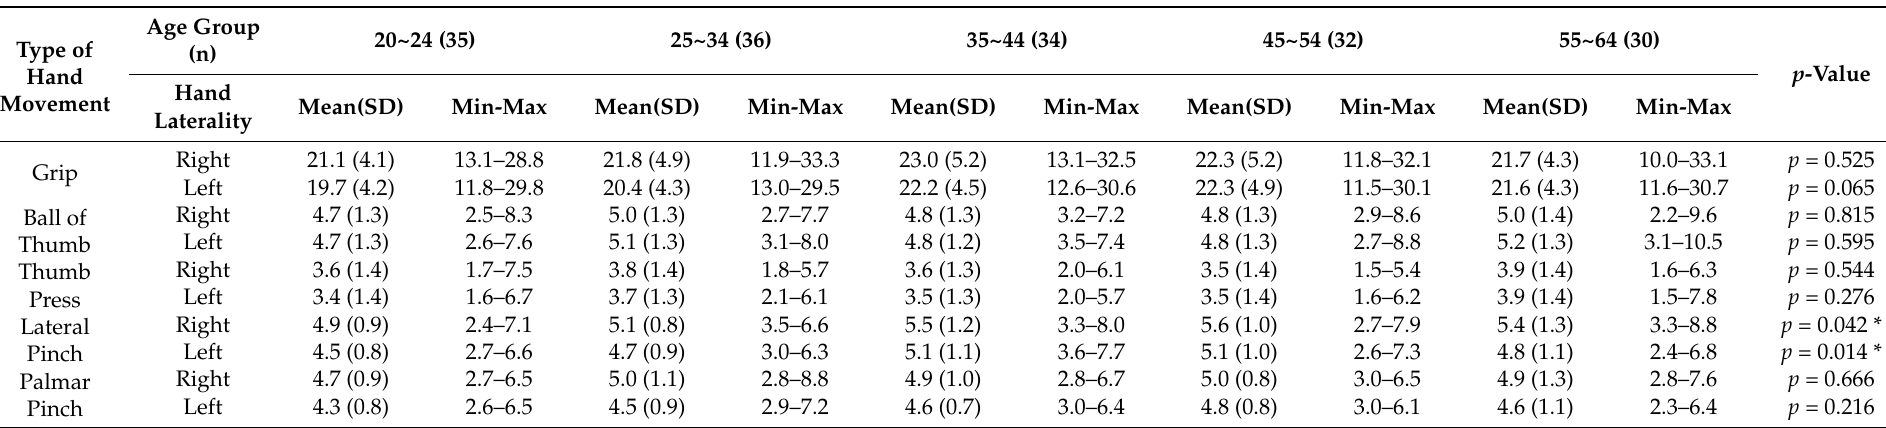
Table 4. Summary of Strength data by age, type of hand movements and hand laterality among females ( n = 167, unit: